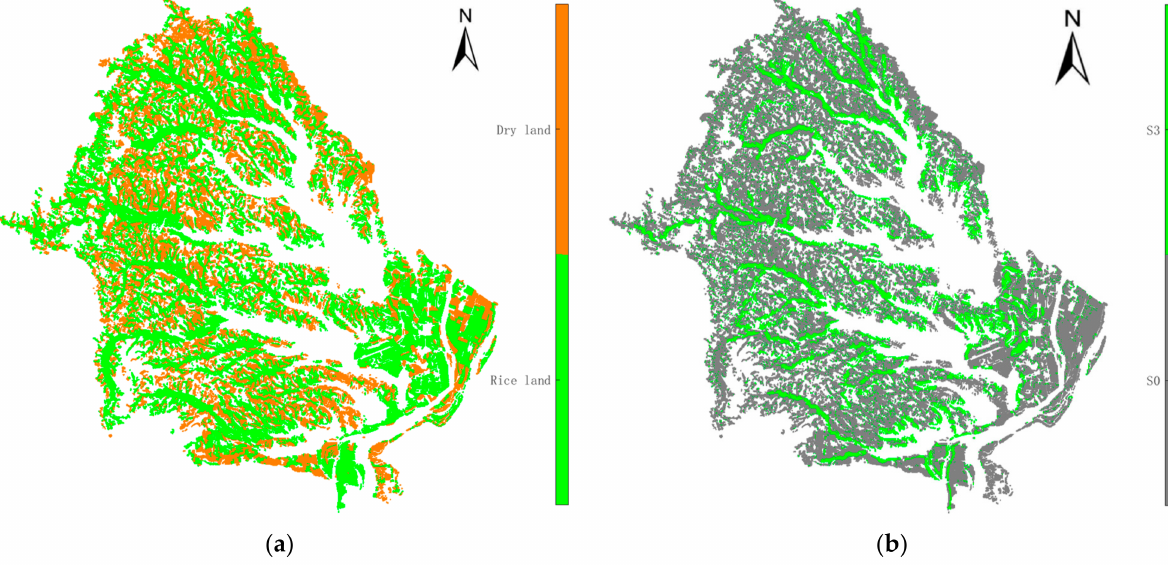
Figure 6. The spatial distribution of farmland ( a ) and S3 target region ( b ) at grid